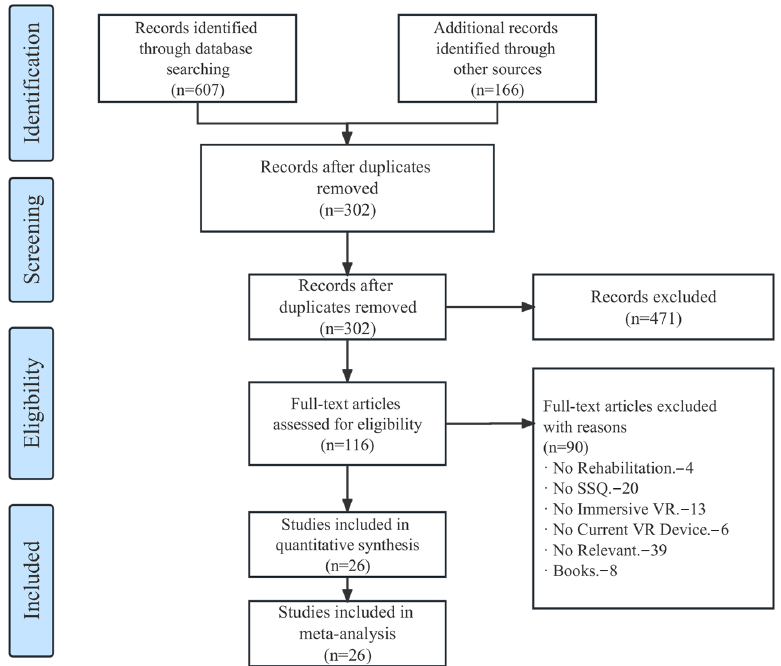
Figure 2. The PRISMA flow diagram for the systematic review detailing the selection process.